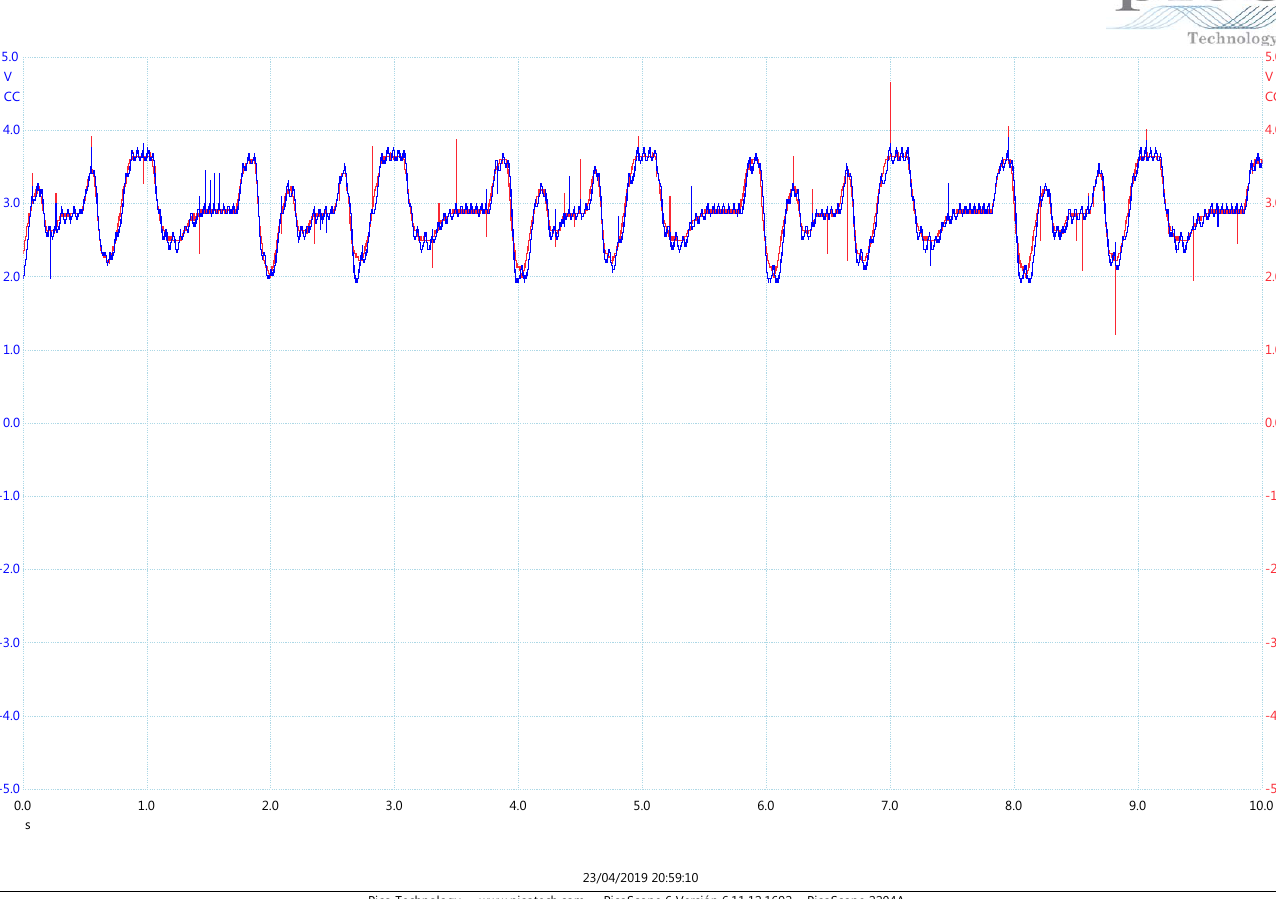
Figure 11. Experimental measurements. The blue line is the measured throttle angular position and the red line is the desired throttle motion. By using a class of random reference programming, the ability of the controller to lead this kind of time-varying signal is notably